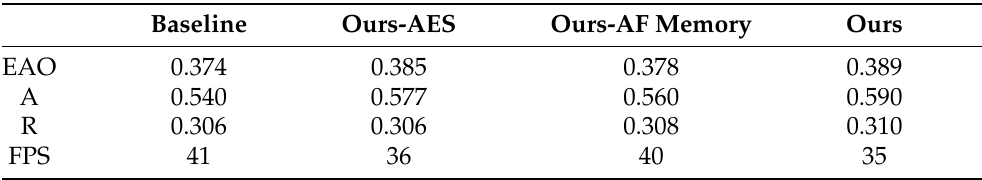
Table 1. Ablative experiments on the VOT2016.